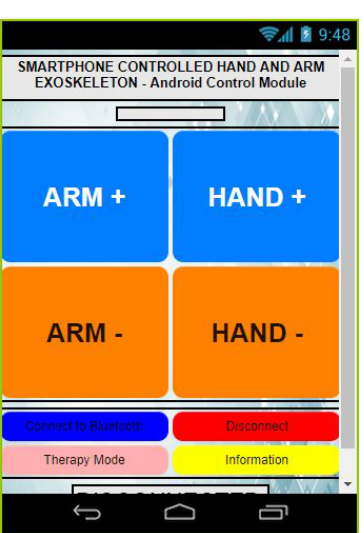
Figure 6: User interface of the Android application installed in the smartphone for